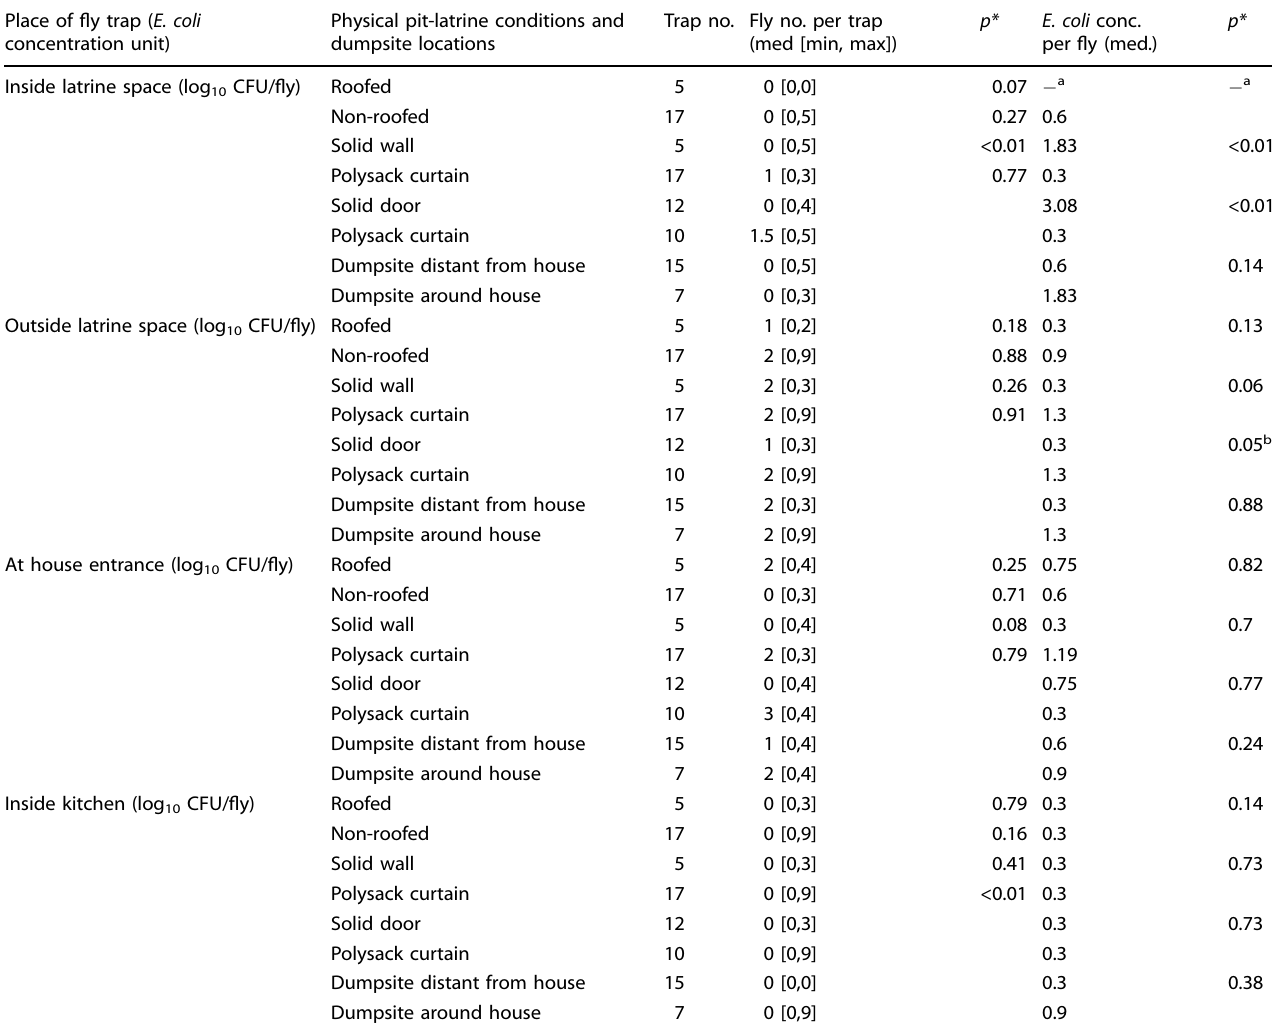
Table 7. Fly numbers and E. coli concentration of fl ies by physical pit-latrine conditions and dumpsite locations. Place of fl y trap ( E. coli Physical pit-latrine conditions and concentration unit) dumpsite